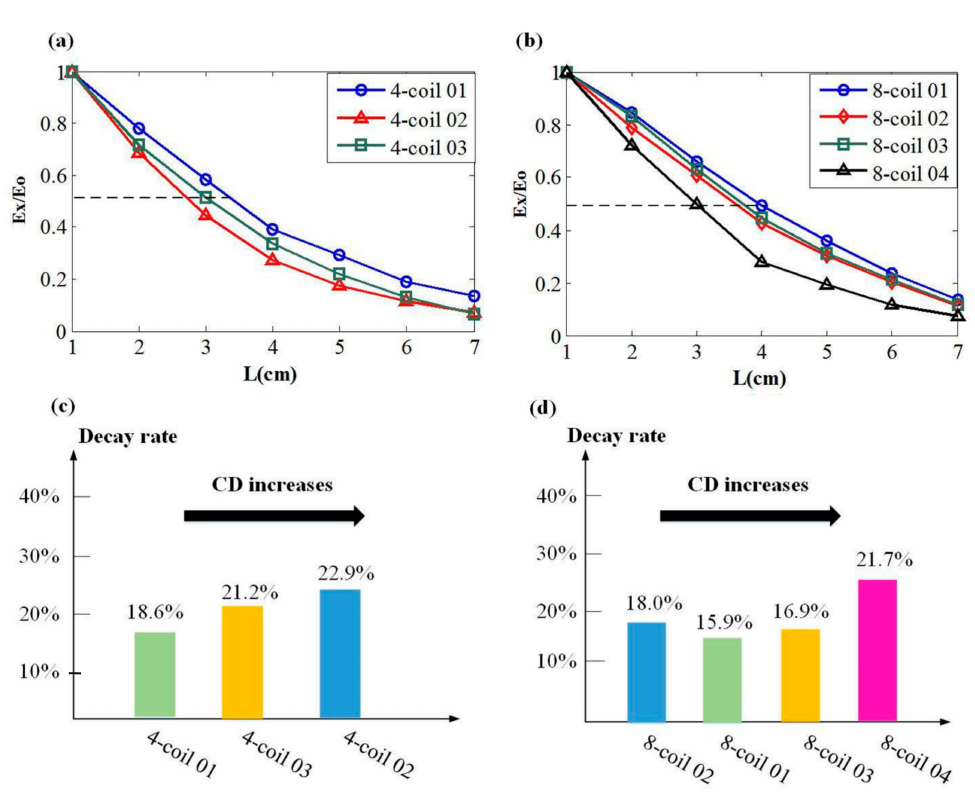
Figure 5. Relationship between the electric field (EF) intensity and the depth of specific brain regions. ( a ) The intensity attenuation profiles of 4-coil combinations. Here, L indicates the distance from the surface of the head model along the direction passing through the brain center. E X represents the EF intensity of a targeted depth, and E O is the value of cortical EF intensity. ( b ) The intensity attenuation profiles of 8-coil combinations. ( c ) Relationship between the decay rate of induced EF strength and the value of CD among the 4-coil group. ( d ) Relationship between decay rate of field intensity and the CD level of 8-coil